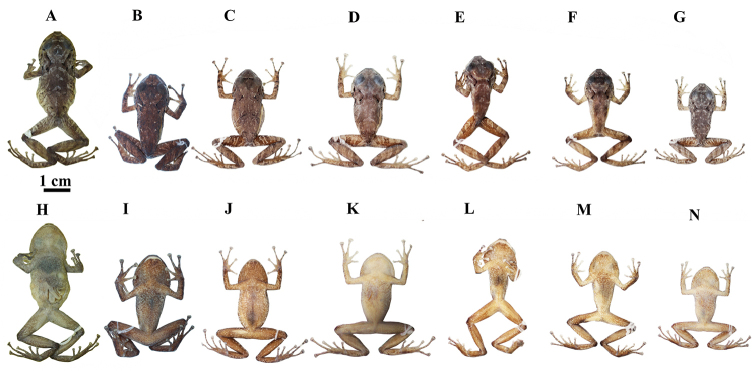
Preserved individuals of Pristimantismallii sp. n. showing dorsal and ventral variation in adult females A–G dorsal view H–N ventral view. A, HZSFQ 1305, SVL = 34.3 mm B, IDHMECN 5236, SVL = 30.9 mm C, JQCAZ 52494, SVL = 29.3 mm D, KQCAZ 52473, SVL = 28.8 mm, holotype E, LQCAZ 39777, SVL = 26.5 mm F, MQCAZ 52477, SVL= 24.7 mm G, NQCAZ 52476, SVL = 24.0 mm.